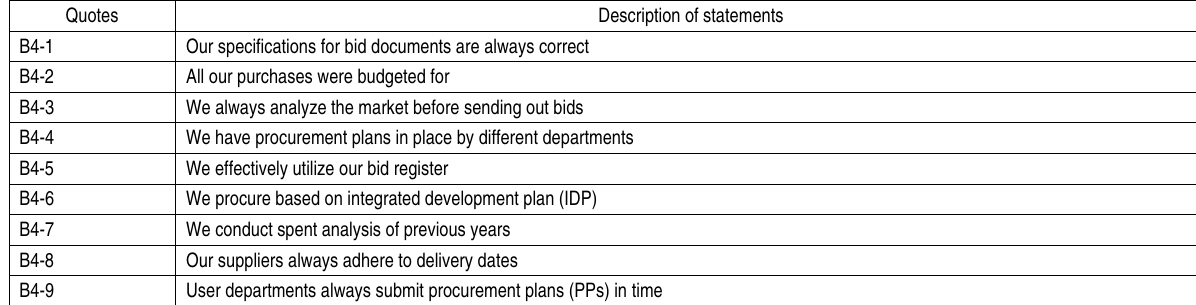
Table 3. Description of statements used in Table 2 relating to demand management